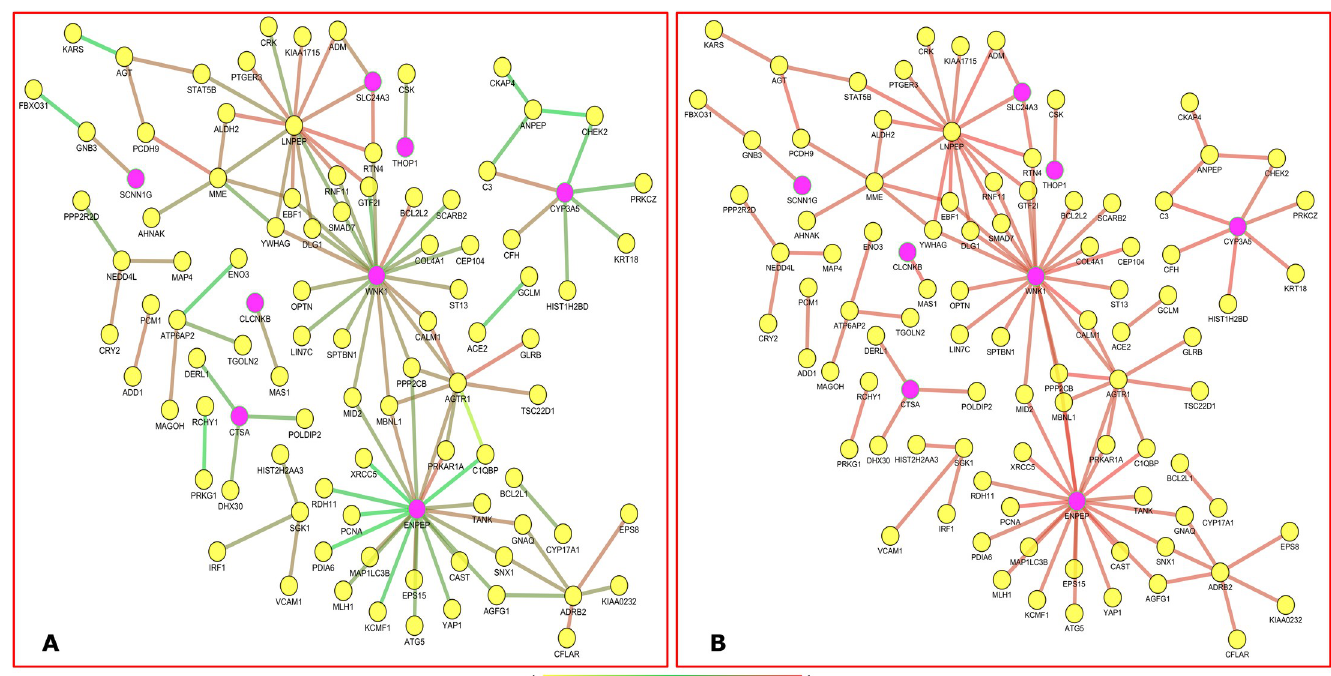
Fig 5. The plot depicts the correlation score of gene pairs in obese and control conditions. The color scale (-1 to +1) represents the correlation value. Higher the value higher is the correlation. (A) Represents gene-gene correlation in normal samples and (B) represents their corresponding correlation in obese condition. Pink nodes depict novel genes that are co-expressed with obesity related genes in obese condition and Yellow nodes represent obesity related genes.